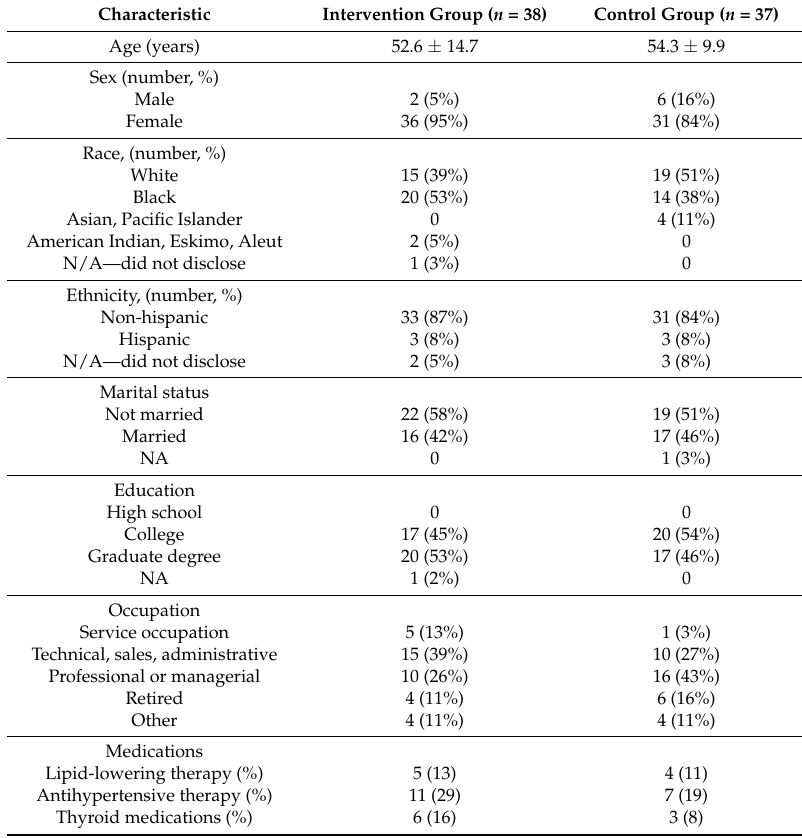
Figure 1. Enrollment of the participants and completion of the study. Table 1. Baseline characteristics of the Study Population. Data are means ± SD, or number (%). p -values refer to t -tests for continuous variables and χ 2 for categorical variables. The p -value calculated for ethnicity distribution is for the comparison between Hispanic vs. non-Hispanic categories.